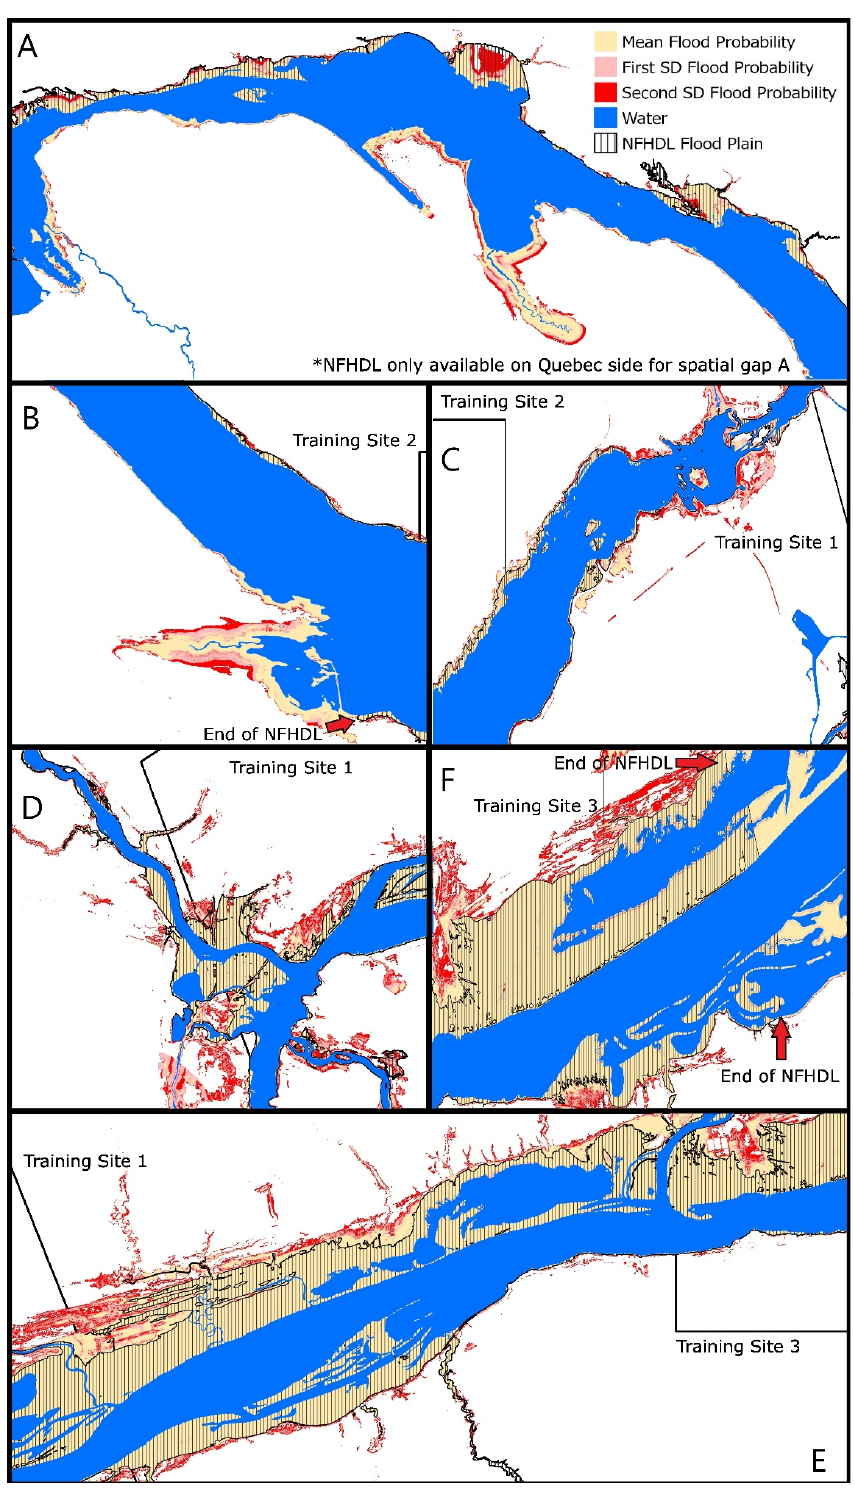
Figure 8. Validation of the final flood susceptibility map polygons at the locations of existing spatial gaps within the FDRP flood hazard areas as shown in Figure 7 with circles ( A – F ). The NFHDL maps do not cover the Ontario side for spatial gap A and most of spatial gap B. For spatial gap F, the NFHDL maps end midway on both the Quebec and Ontario side. The end of the NFHDL coverage is indicated by red